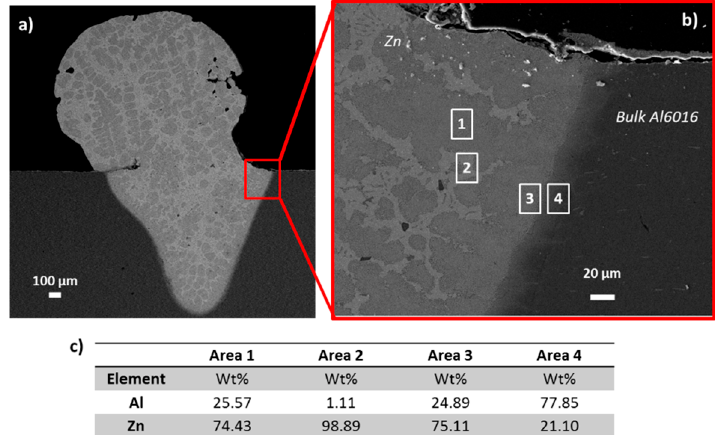
Figure 6. Field-emission scanning electron microscopy–energy-dispersive spectroscopy (FESEM-EDS) analyses of Al6016-flux-Zn. ( a ) Micrograph of the drop/reaction layer; ( b ) magnification of the reaction layer/interface; and ( c ) semiquantitative EDS analyses of selected area evidenced in panel ( b ).